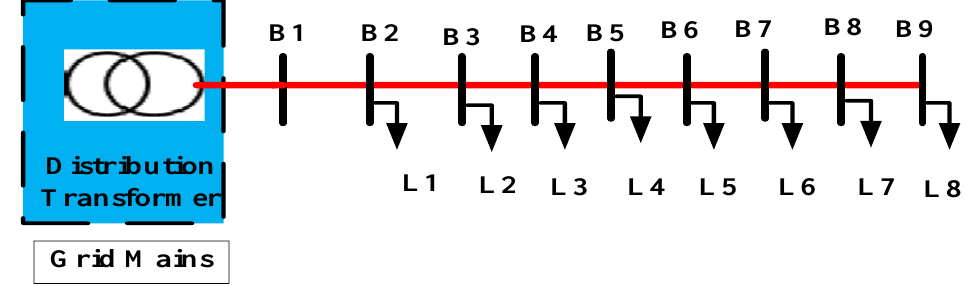
Figure 3. Single-line diagram of the radial distribution system under consideration